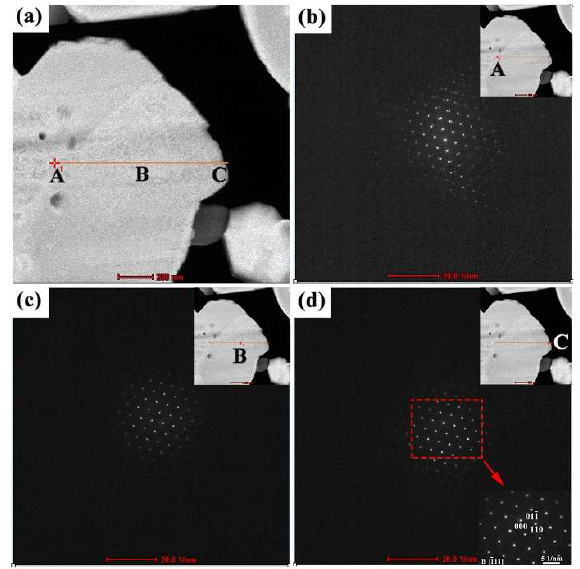
Figure 8. Crystal structure of the W matrix in scandate cathode #1, characterized using scanning nanobeam diffraction. ( a ) HAADF image showing the selected tungsten grain; ( b – d ) diffraction patterns corresponding to the sites of A, B and C as marked in ( a ). It is demonstrated that the W matrix has the BCC structure, which is inferred from diffraction patterns obtained at locations ranging from the middle of the W grain to its surface. The beam direction and zone axis for the grain orientation shown here are indexed as [−111].